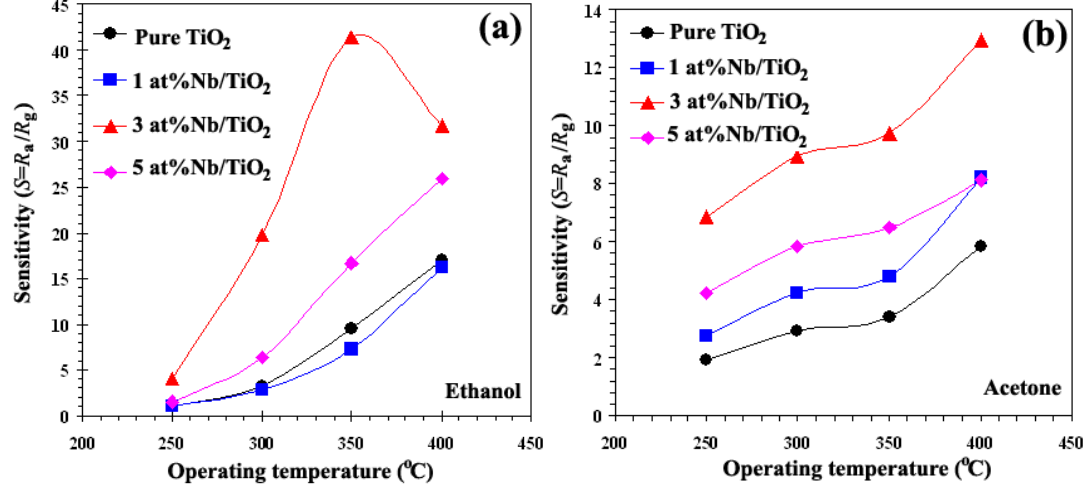
Figure 3. The sensitivity as a function of sensor operating temperature for undoped and doped with different Nb concentrations (1, 3, and 5 at.% Nb) for (a) ethanol and (b) acetone vapors in dry air atmosphere.